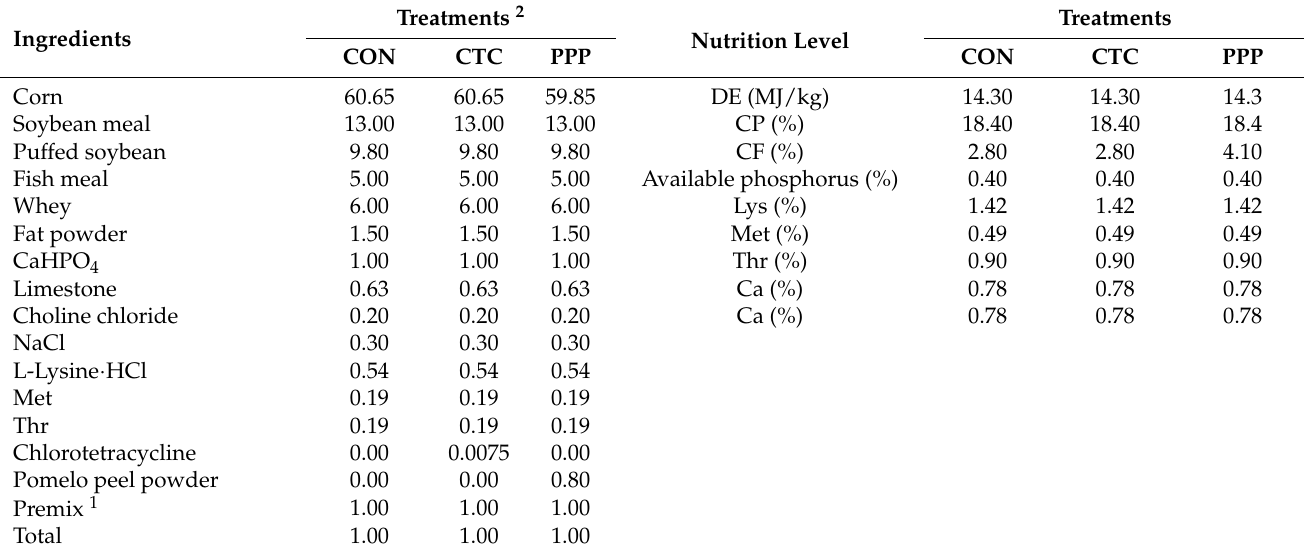
Table 1. Dietary compositions and nutrition level ( % , air-dry